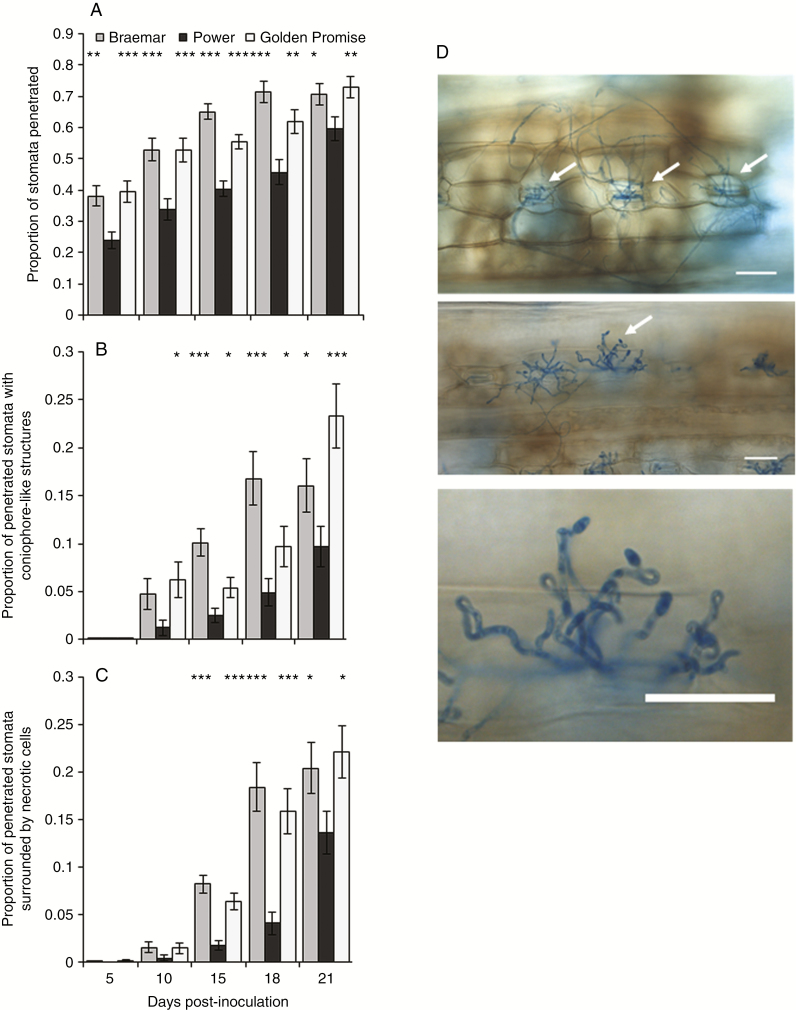
Microscopic comparison of Ramularia collo-cygni infection in the spring barley varieties Braemar, Power and Golden Promise during an infection time course. (A) Proportion of stomata penetrated by R. collo-cygni hyphae. (B) Proportion of penetrated stomata with conidiophore-like structures emerging. (C). Proportion of penetrated stomata surrounded by reddish-brown necrotic areas. Error bars indicate ±1 s.e.. (D) Images of microscopic development of R. collo-cygni infection under ×20 magnification. (i) Stomata penetrated by R. collo-cygni hyphae (arrows) surrounded by reddish-brown necrotic regions. (ii) Ramularia collo-cygni conidiophores (arrows) erupting from stomata. (iii) Close-up of R. collo-cygni conidiophore highlighting the characteristic swan-neck shape. Scale bar = 50 μm. Data were analysed using a generalized linear model of binomial proportions. ***P < 0.001; **0.001 < P < 0.01; *0.01 < P < 0.05.